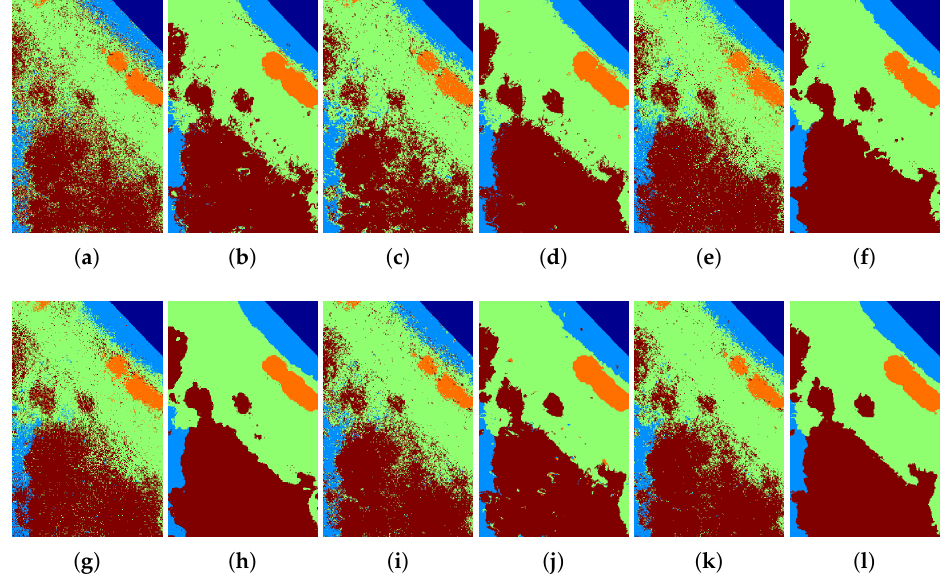
Figure 18. Classification maps of the ( a ) ELM, ( b ) ELM + GFFPC, ( c ) KELM, ( d ) KELM + GFFPC, ( e ) KSVM, ( f ) KSVM + GFFPC, ( g ) CNN, ( h ) CNN + GFFPC, ( i ) MELM, ( j ) MELM + GFFPC, and the proposed ( k ) DKELM, and ( l ) DKELM + GFFPC for the Glycine ussuriensis